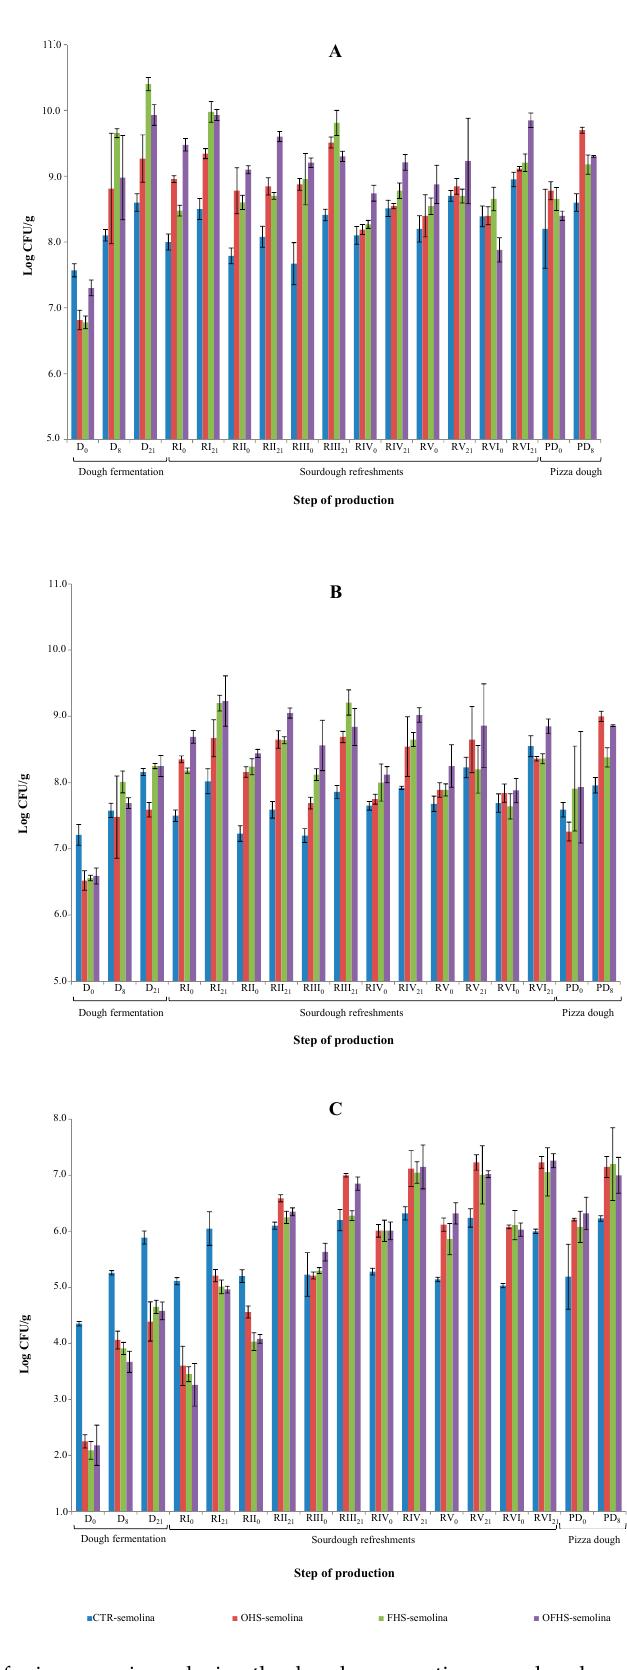
Figure 3. Levels of microorganisms during the dough preparation, sourdough propagation, and pizza dough production. ( A ) Lactic acid bacteria, ( B ) total mesophilic counts, and ( C ) yeasts.